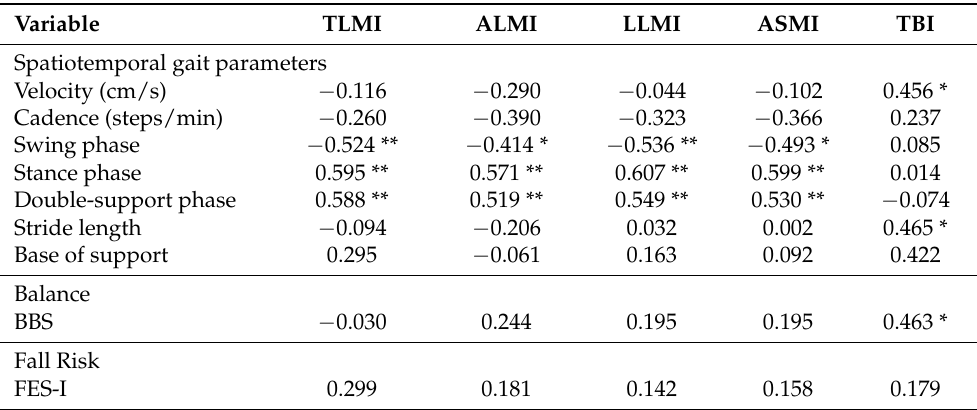
Table 3. Correlation between muscle volume and spatiotemporal gait